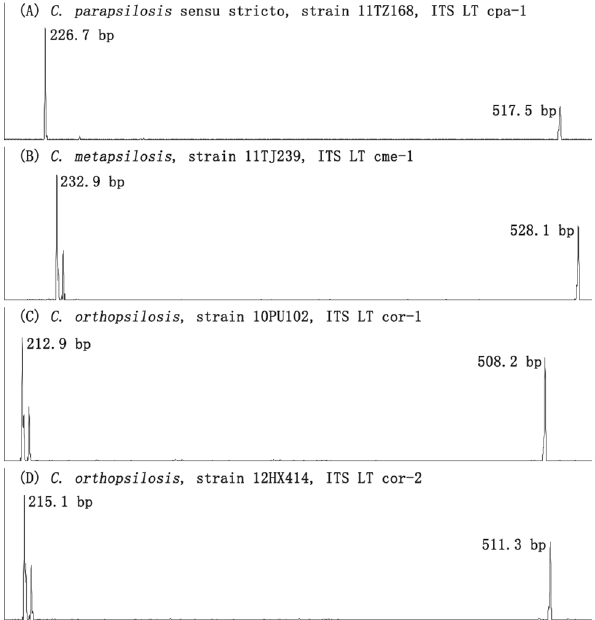
Fig 3. ITS length types (LTs) within C . parapsilosis species